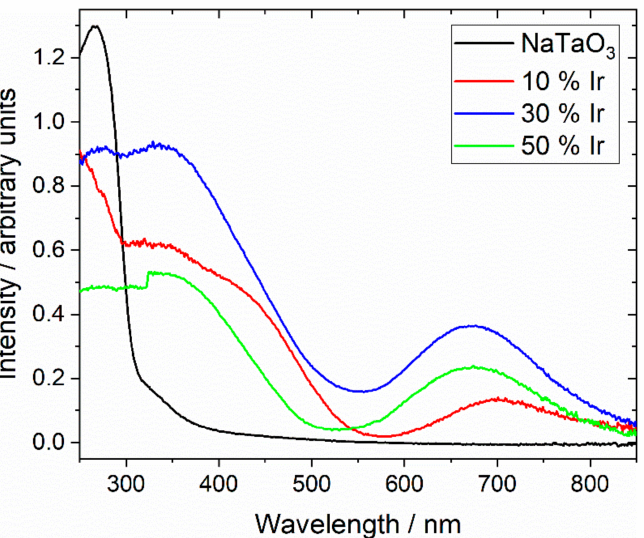
Figure 7. Diffuse-reflectance UV-vis spectra of Ir-substituted NaTaO 3 materials labelled according to the proportion of Ir added in